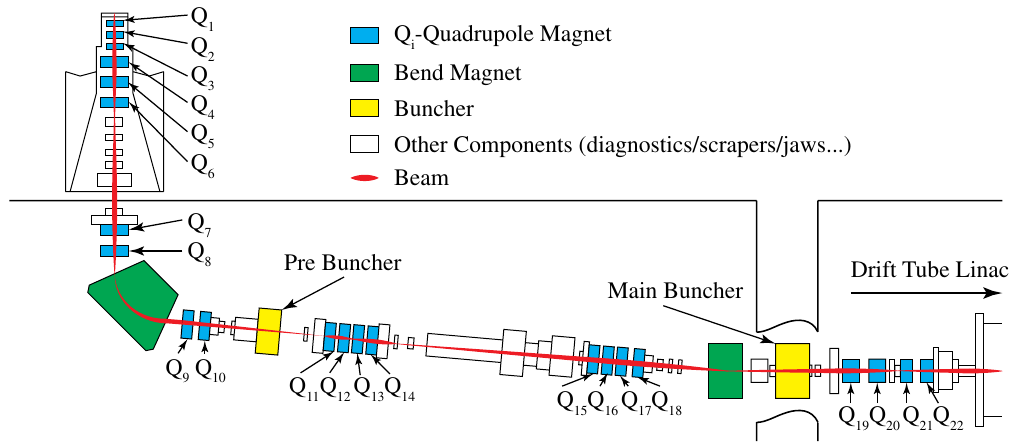
FIG. 3. Simplified schematic of the LANSCE H þ injector and transport